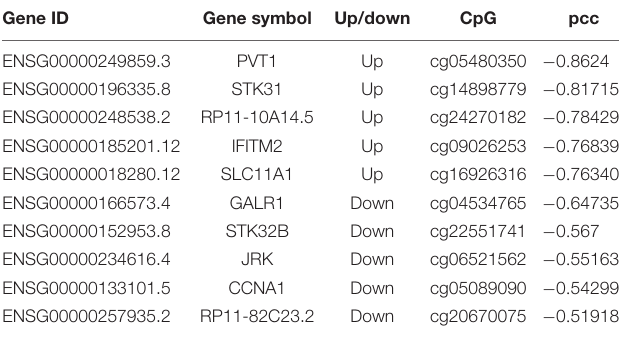
TABLE 3 | Potential DNA methylation-regulated lncRNAs in gastric